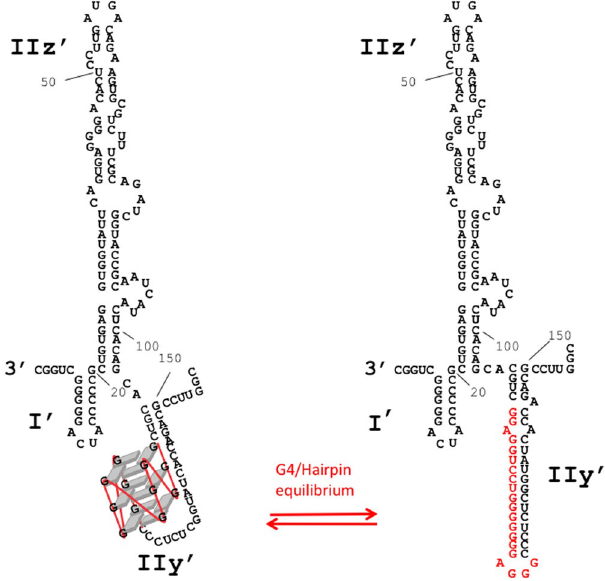
Figure 5. Schematic representation of alternative structures for an optimal RNA synthesis. The stem loop IIy’ could be folded either into a G-quadruplex conformation (left) or in Watson-Crick duplex conformation